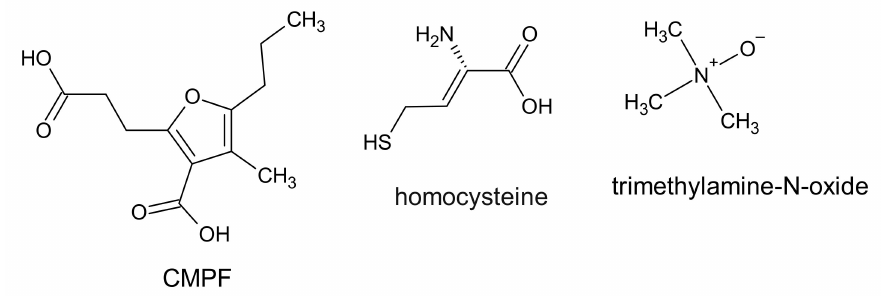
Figure 6. Chemical structure of CMPF, homocysteine, and trimethylamine-N-oxide, classified as protein-binding uremic